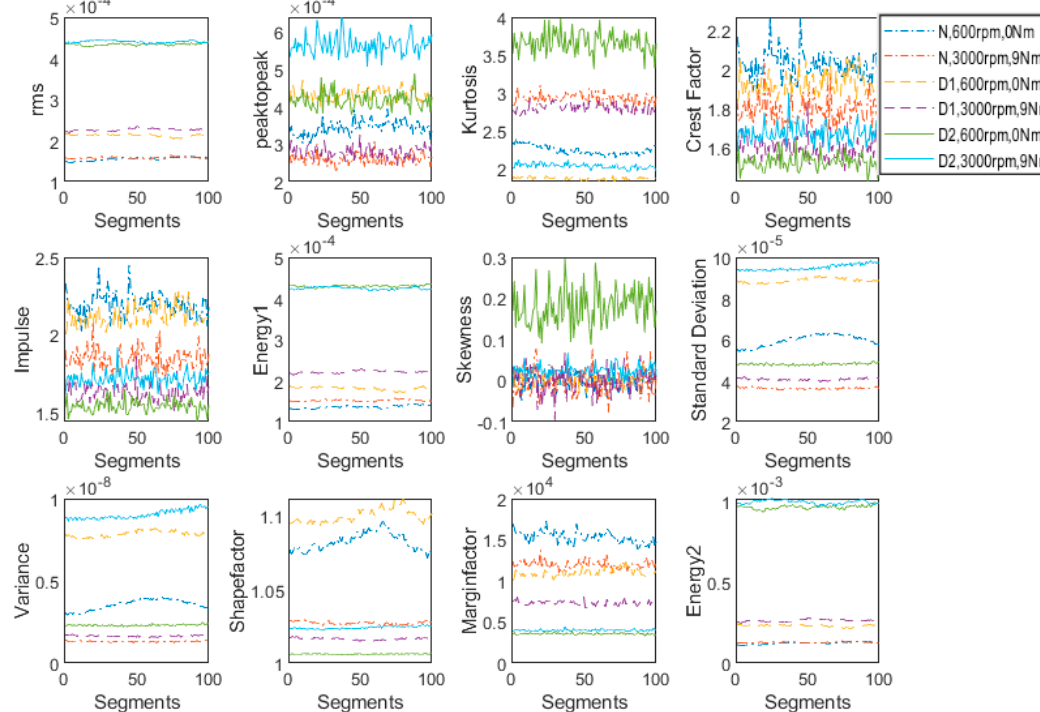
Figure 10. Features’ plot for normal, 1 tooth broken and 2 teeth broken gear boxes at extreme operating conditions .